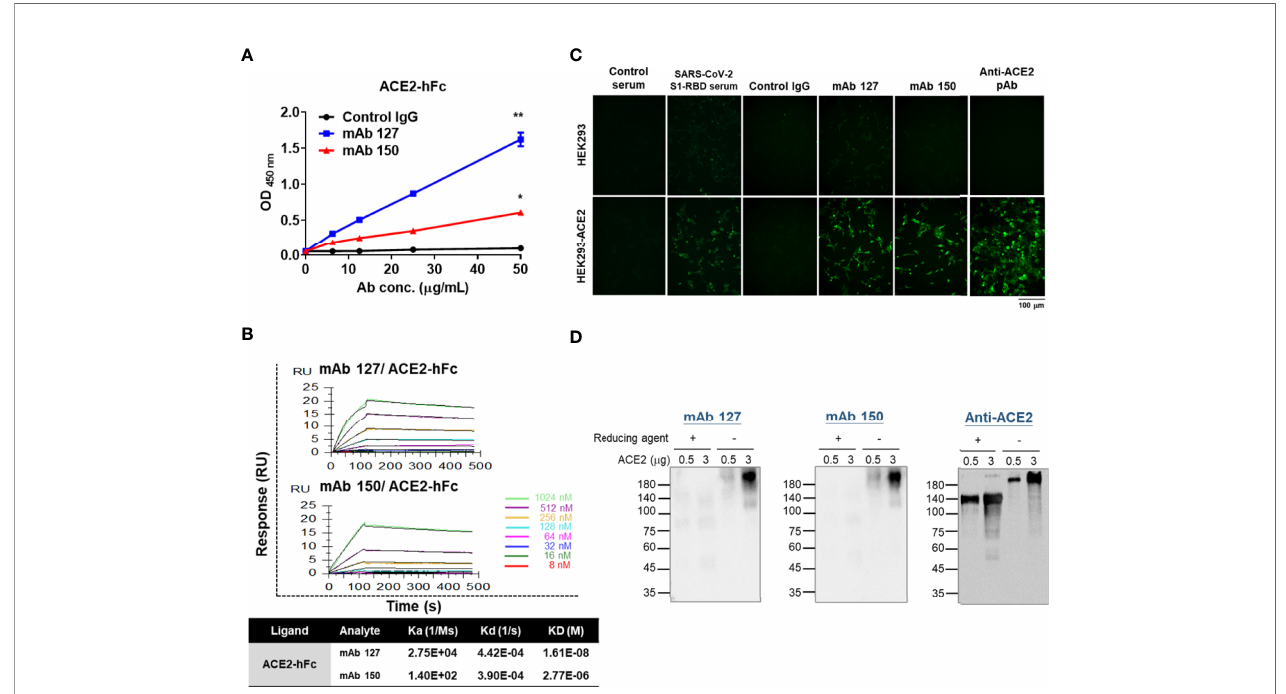
FIGURE 4 | Characterization of the binding properties of mAbs 127 and 150 to ACE2. (A) The dose response of mAbs 127 and 150 and control IgG binding to ACE2-hFc was analyzed by indirect ELISA. (B) Binding af fi nity of mAbs 127 and 150 to ACE2. ACE2-hFc-bound sensors were incubated with the indicated concentrations of mAb 127 or 150 for a set time interval to allow association. The sensors were moved to protein-free solution and allowed to dissociate over a time interval. The binding kinetics were determined using Biacore T200 Evaluation Software version 3 with 1:1 binding model fi tting. (C) HEK293 and HEK293-ACE2 cells were fi xed and stained with control sera, SARS-CoV-2 S1-RBD-immunized sera (1:400), control IgG, mAb 127 or 150 or anti-ACE2 pAb (5 m g/mL) and then visualized with an immuno fl uorescent assay. (D) Western blotting analysis of mAb 127 or 150 or anti-ACE2 pAb binding to 0.5 or 3 m g of ACE2 in the presence or absence of a reducing agent as indicated. All statistical data are presented as the means±S.Ds. from at least two independent experiments. *P<0.05,